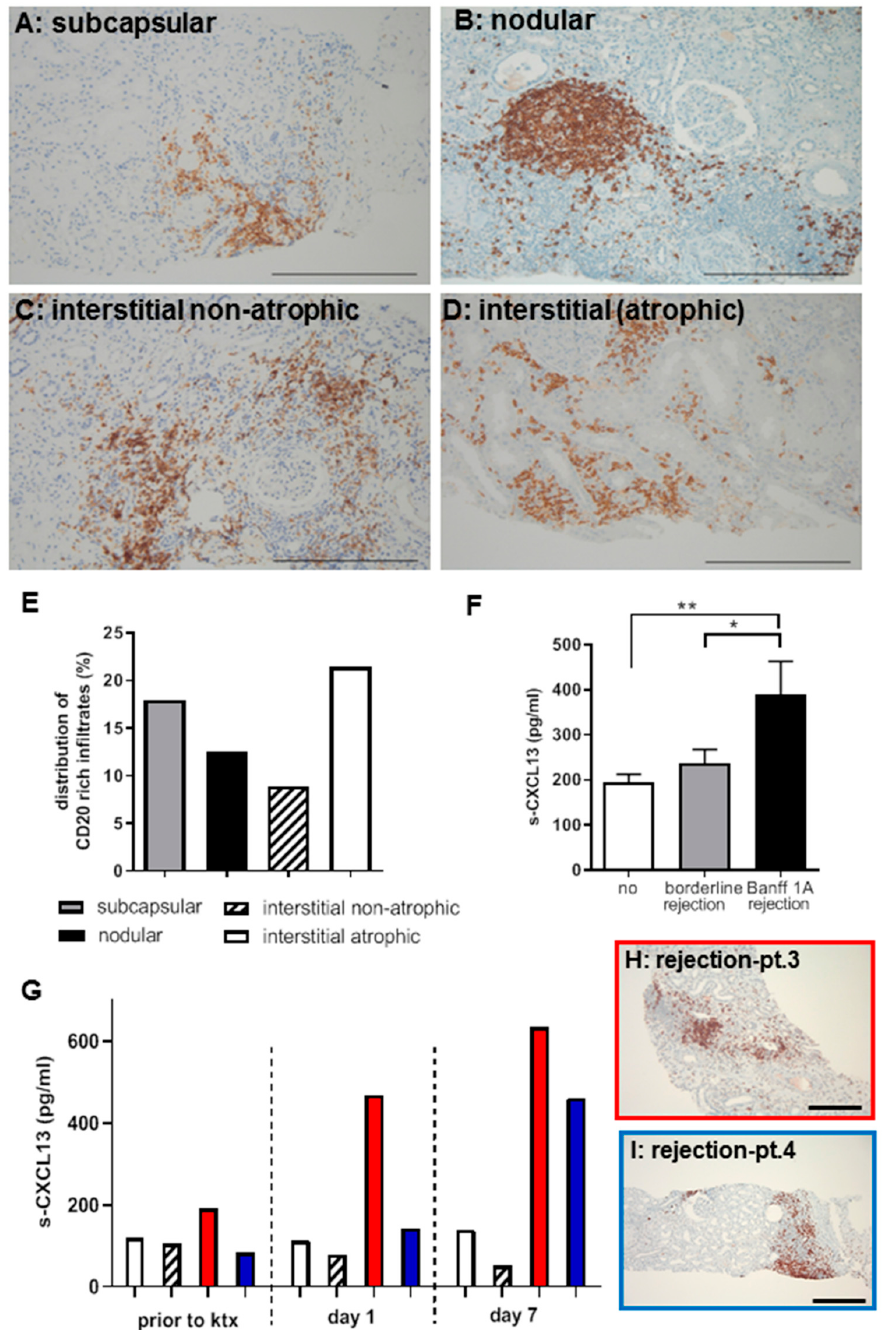
Figure 1. CD20 + cells were detected as part of inflammatory infiltrates in patient biopsies with TCMR ( A – D , bar: 100 µ m)) in subcapsular, tubular-interstitial (atrophic and non-atrophic) areas as well as in nodular infiltrates. In the non-rejection state, no CD20 positivity is detectable (data not shown). CD20 + cells were quantified in 67 randomly selected human biopsies with TCMR and graded as B-cell rich ( > 30 CD20-positive cells / hpf). In subcapsular infiltrates, 17.9%, in interstitial-nodular infiltrates, 12.5%, and in interstitial / atrophic areas, 21.4% were B-cell rich. The Ban ff -relevant interstitial non-atrophic areas contained 8.9% B-cell rich infiltrates ( E ). Serum CXCL13 levels are increased in patients with TCMR (Ban ff 1a) compared to patients with borderline or no rejection (** p = 0.01; * p = 0.05) ( F ). Four patients had CXCL13 measurements during the first week after ktx ( G ). All had low levels of CXCL13 prior to ktx and two patients developed a relevant increase of CXCL13 levels up to day 7. Biopsy revealed a rejection with B-cell rich infiltrates ( H , I , bar: 200µm).